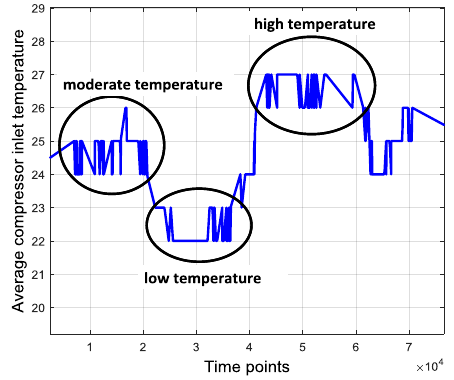
Figure 4. Disturbance of ambient temperature.